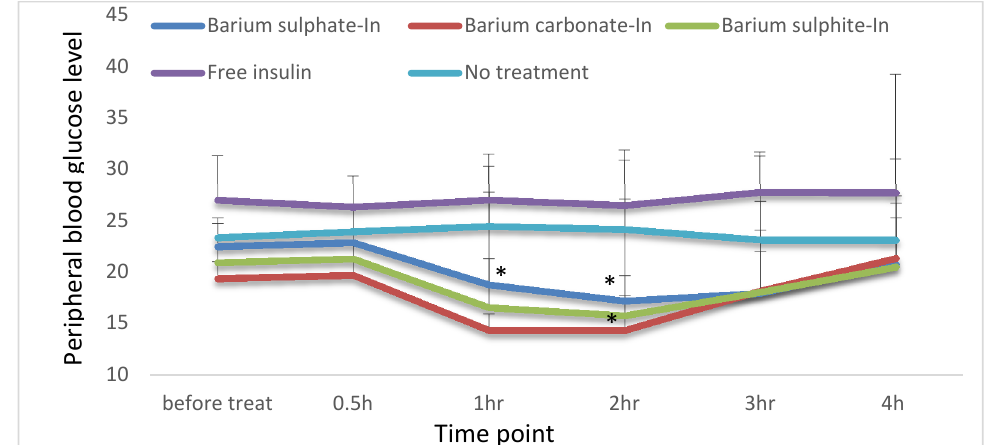
Figure 13. Oral delivery of free insulin and particle loaded insulin effect on hyperglycemia. The group of STZ-induced diabetic rats without any treatment was taken as a negative control, whereas the group of STZ-induced diabetic rats treated with free insulin was considered as a positive control. 3 different treatment groups of diabetic rats were orally given Insulin aspart-loaded particles of BaSO 4 , BaSO 3, and BaCO 3. Each control and treatment groups have 3 animals per group. The baseline blood glucose level was read before the treatment. All 3 insulin-loaded Ba salt formulations showed a reduction in blood glucose level within 1 h of the oral administration. Mean value of (±standard deviation) was plotted for BaSO 4 , BaSO 3 , and BaCO 3 loaded with Insulin aspart (100 IU/kg) ( p < 0.05) . For BaSO 4 particles with loaded insulin, blood glucose level was significantly low compared to the baseline level in 1–3 h ( p < 0.05). At 4th h, the level was still low compared to the baseline level but not significant, with an ascending trend. BaCO 3 particles with loaded insulin showed a significant decrease of blood glucose level at 1–2 h, although blood glucose level started to show a slight rise at 3rd h, and by the 4th h, it was back to the baseline level. However, insulin-loaded BaSO 3 particles showed a reduction in blood glucose level but the reduction was not significant at 4 h.